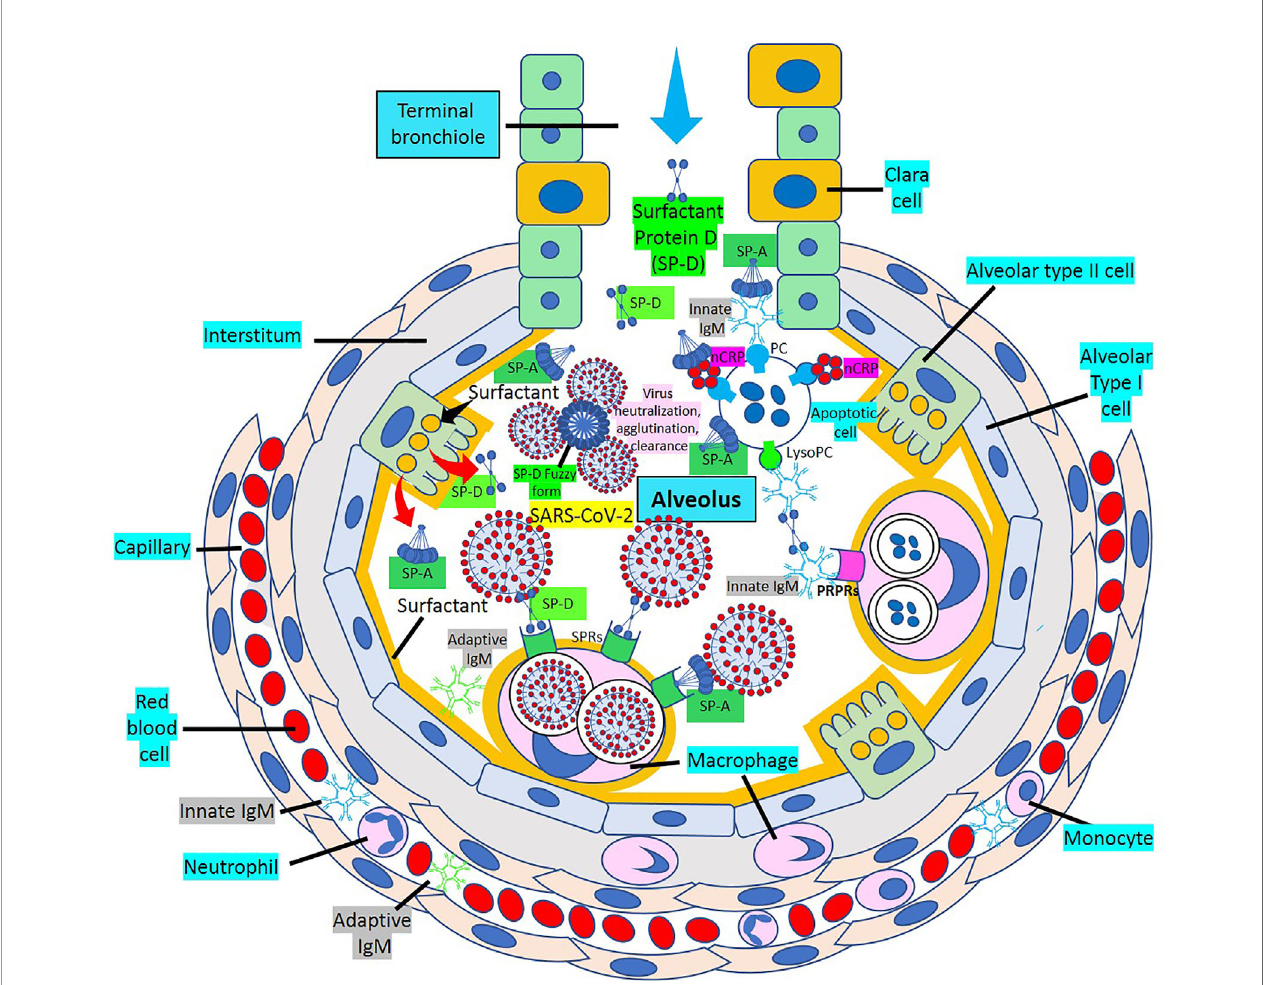
FIGURE 12 | Pattern recognition protein treatment of SARS-Cov-2-related disease. Inhaled surfactant protein D (SP-D) treatment in association with endogenous SP-D and SP-A facilitates neutralization of SARS-CoV-2 particles that can be phagocytosed by alveolar macrophages via surfactant protein receptors (SPRs). Other pattern recognition proteins (PRPs) participate in the removal of apoptotic cells like native pentameric C-reactive protein (nCRP) bound to phosphorylcholine (PC), innate IgM/SP-A, CRP/SP-A and SP-A in apoptotic cells, in association with SP-D and innate/adaptive IgM molecules via pattern recognition protein receptors (PRPRs). lysoPC,